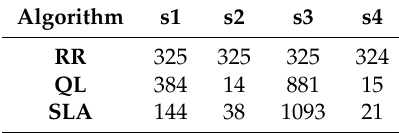
Table 4. Server (feeder link) selection count for Scenario-1